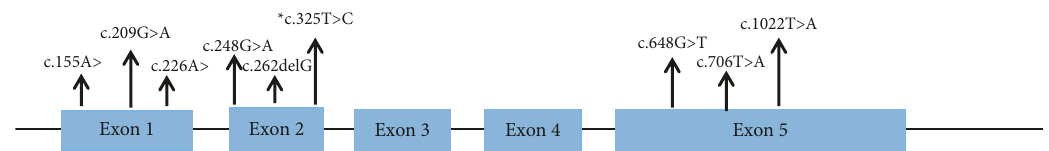
Figure 2: Schematic of nine mutations spanned all exons except exon 3 and 4 were identified in G6PC gene. Mutation c.648G > Tis the most common mutation present in 13 alleles followed with c.248G > T in four alleles. Novel mutation is labelled with ∗ .